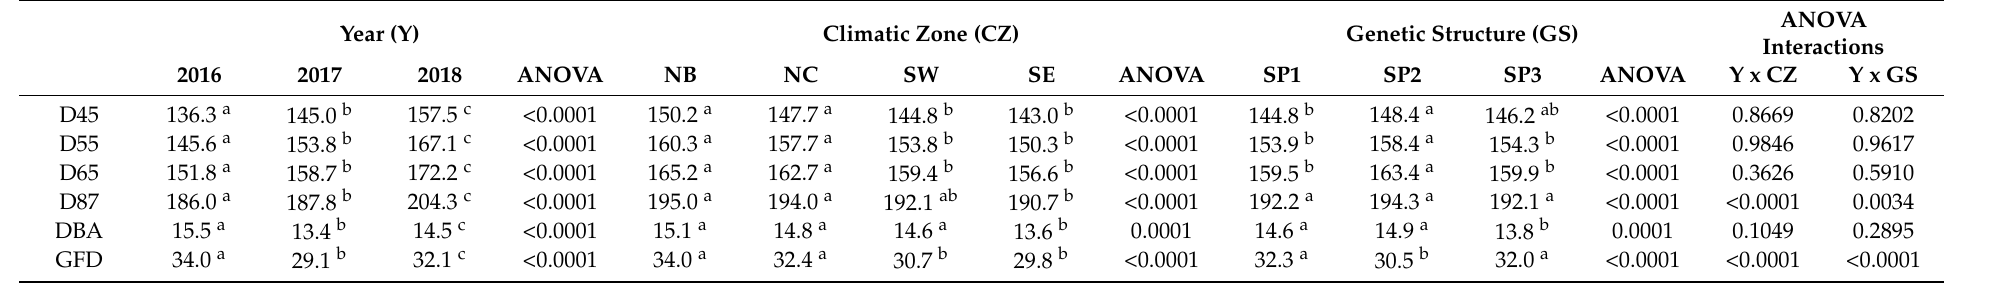
Table 2. Means and ANOVA p -values for the phenology traits analysed in the panel of 153 Mediterranean bread wheat landraces included in the study. Data for each climatic zone and subpopulation (SP) represent the mean values across the 3 years. Different letters at each growing period indicate significant differences at p ≤ 0.05 using the Tukey’s